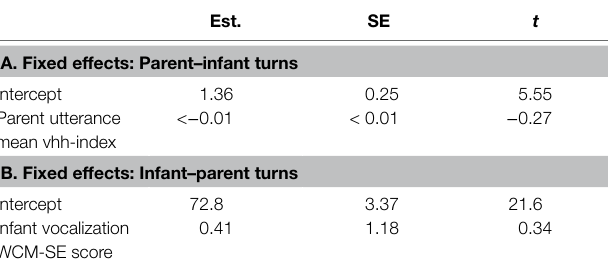
TABLE 4 | Summary of the fixed effects of the analysis of the measure mean vhh-index in parent–infant turns (A) and infant–parent turns (B). No significant effects were